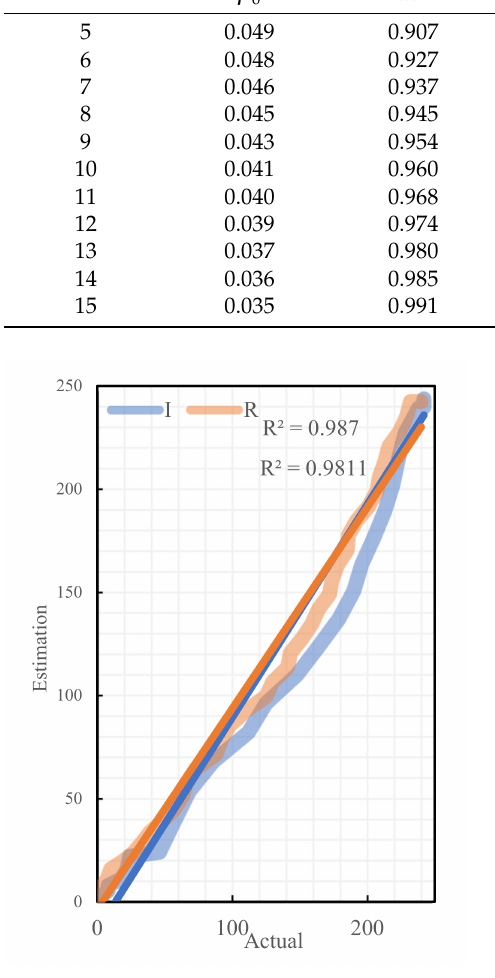
Figure 5. Regressive analysis of actual cases and theoretical